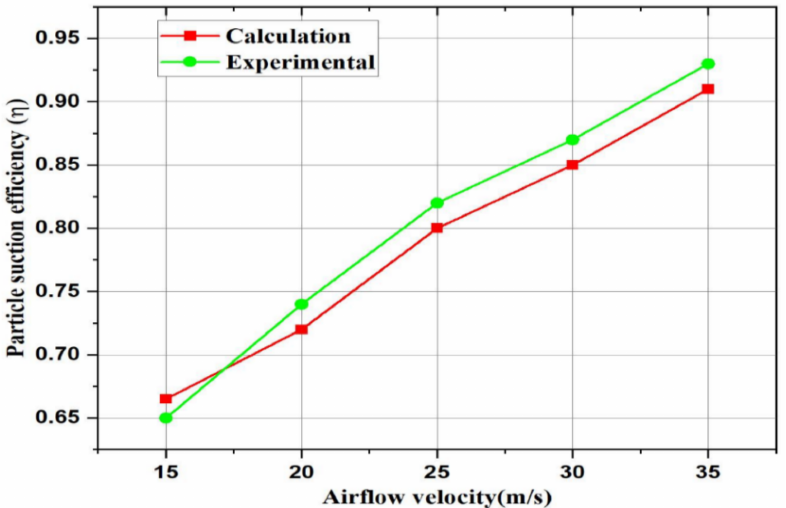
Figure 9. Comparison of the particle suction efficiency on different airflow rate between calculation and